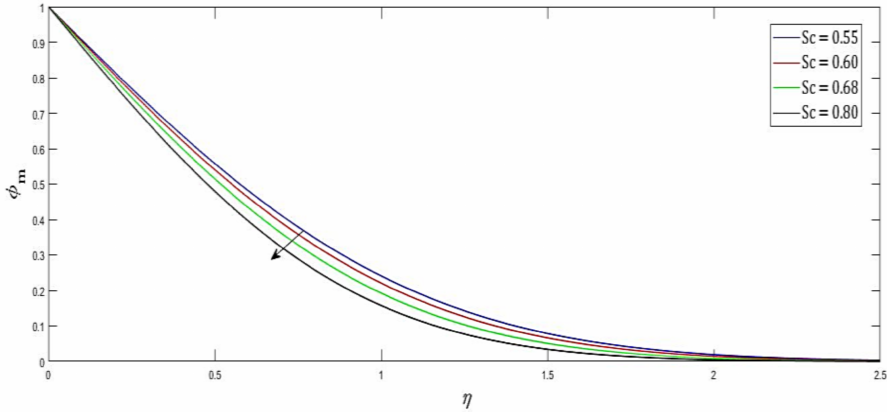
Figure 9. Variation in concentration profile with respect to Schmidt number.